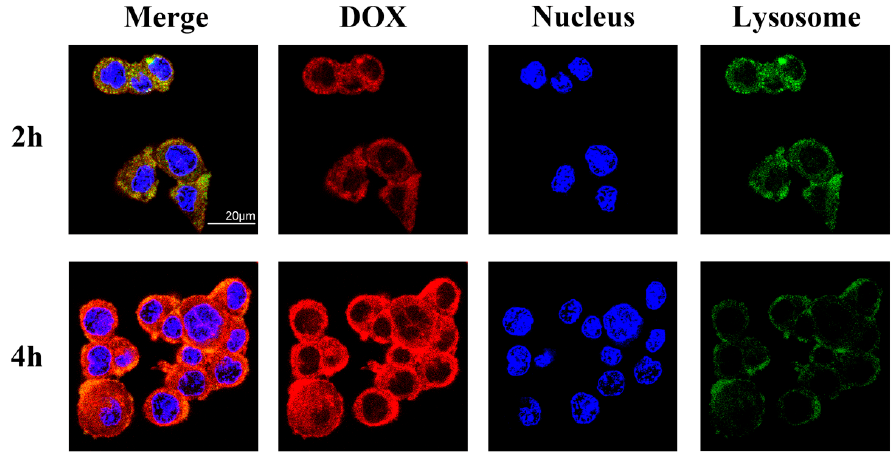
Figure 7. Confocal images of DOC/PCT in B16 cells for 2 h and 4 h. Blue, green, and red colors indicate nucleus, lysosome, and DOX,